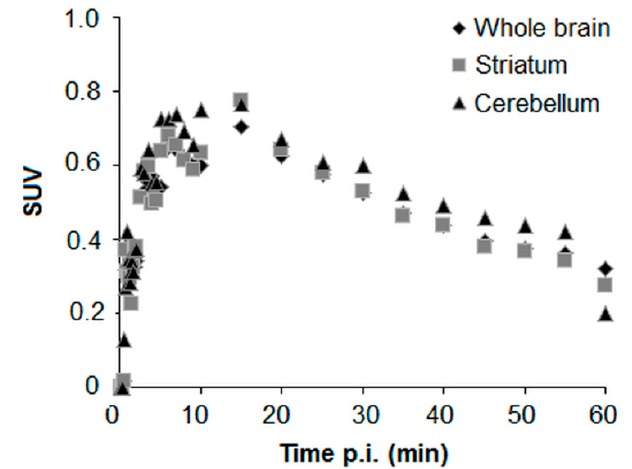
Figure 6. Averaged time-activity curves of [ 18 F] BIT1 in CD-1 mice (n = 2) with standard uptake values (SUV) in the whole brain, striatum, and cerebellum.